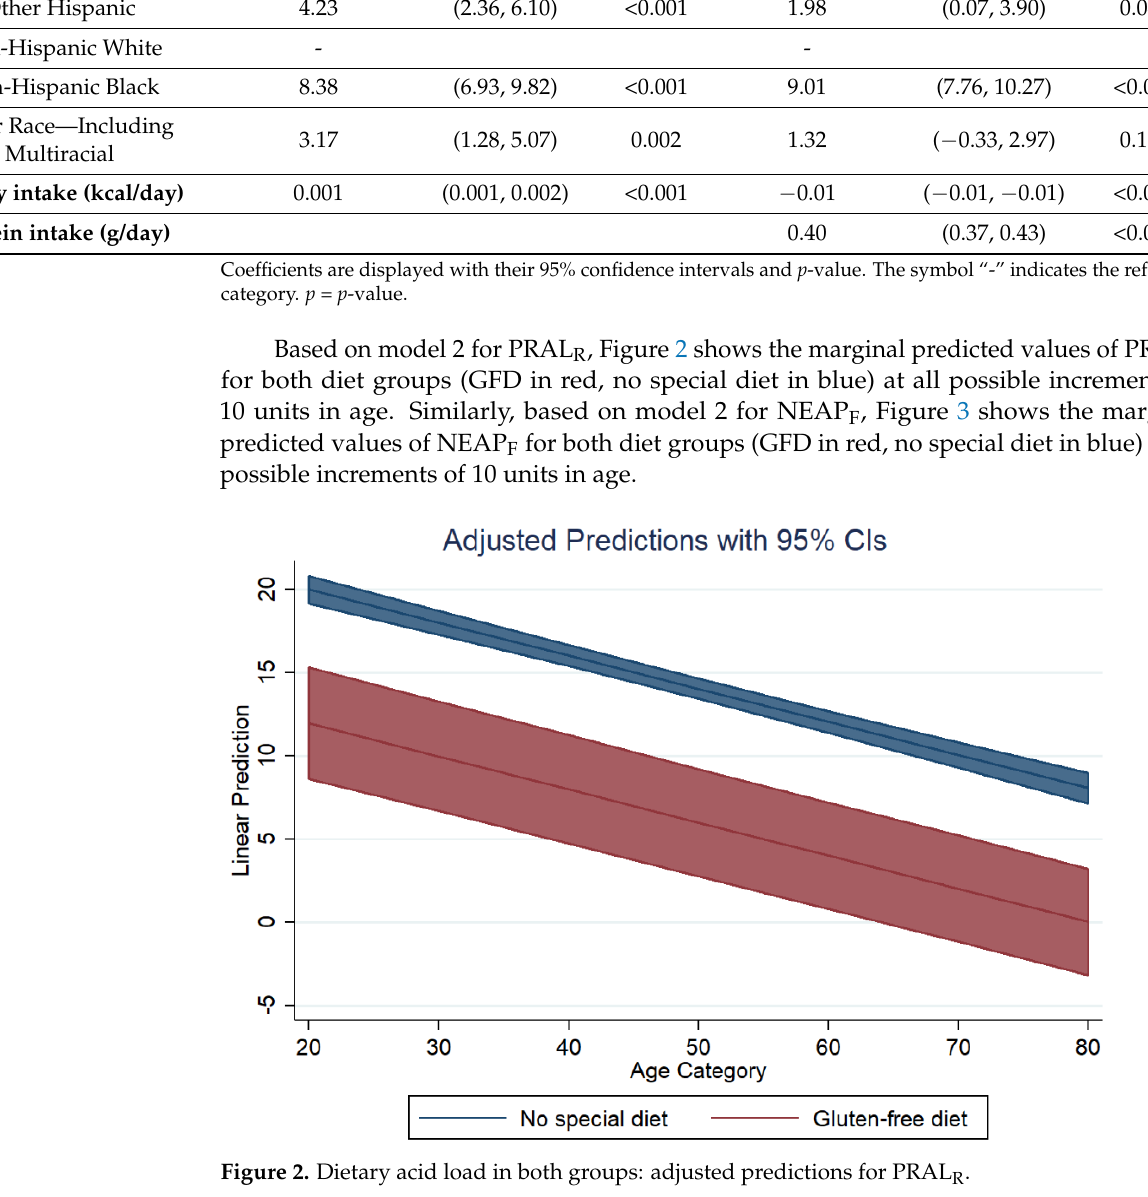
Figure 2. Dietary acid load in both groups: adjusted predictions for PRAL R.